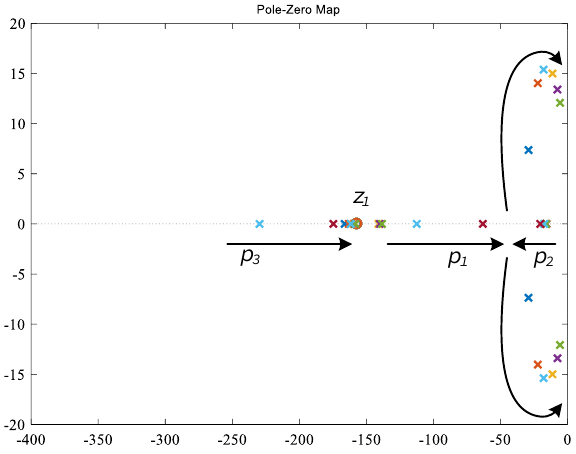
Figure 2. Zero-pole diagram of G r ( s ) with J ω varies.